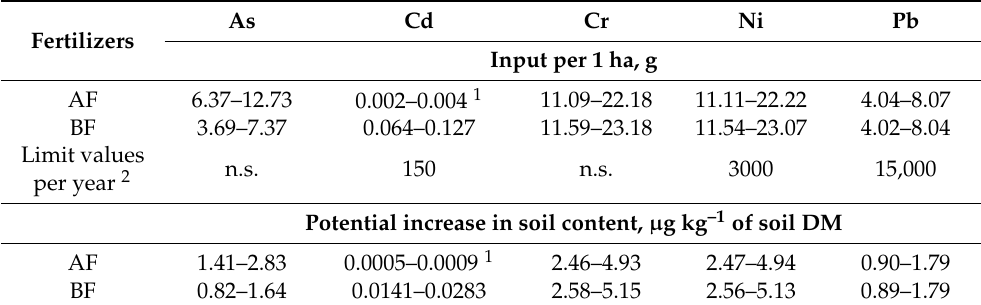
Table 8. Quantities of PTE introduced into soil with biomass-based fertilizers—range between the values for the lowest (17.6 kg ha –1 ) and the highest (35.2 kg ha –1 ) P